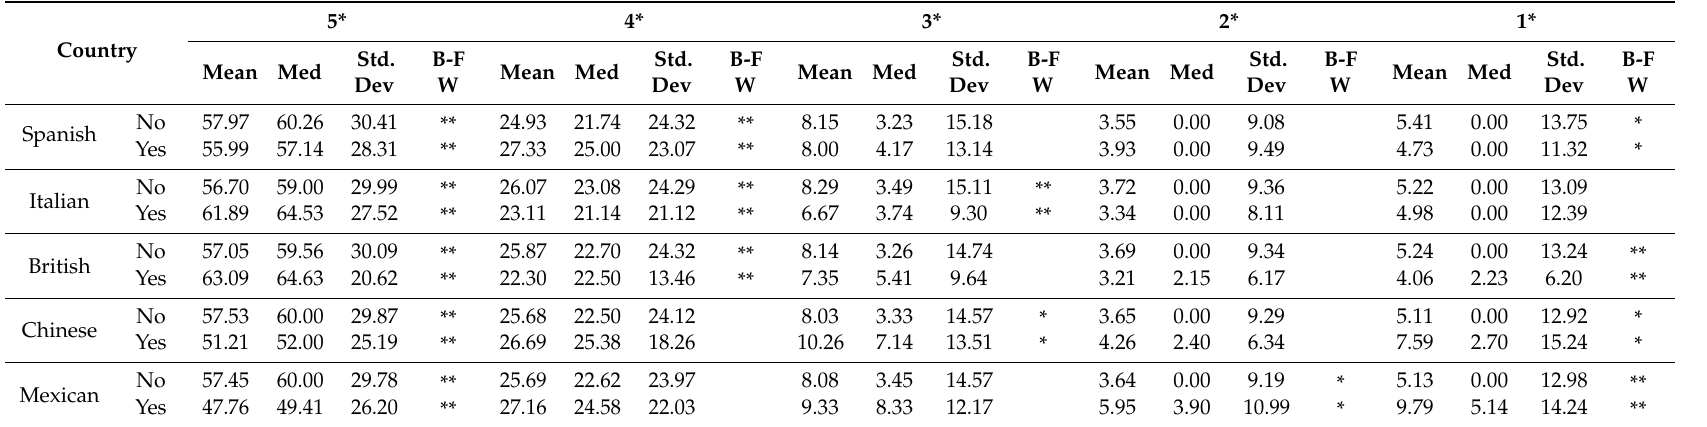
Table A4. Percent of reviews out of total restaurant reviews per score (5*–1*) and per country (Brown–Forsythe and Welch tests). N =